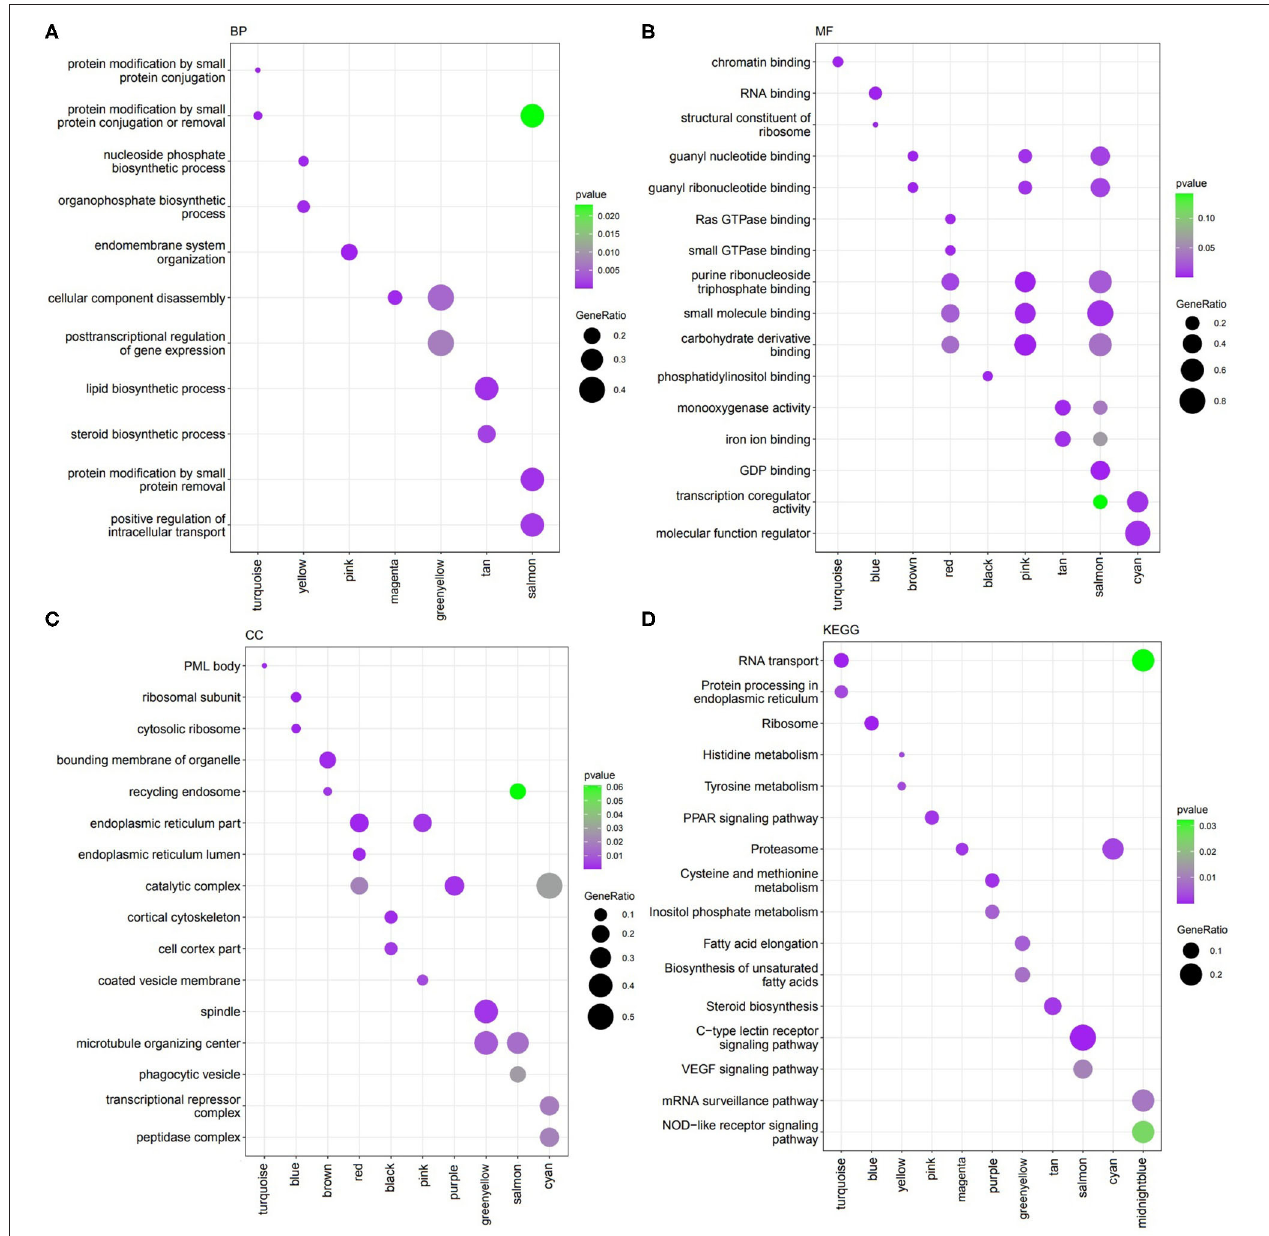
FIGURE 2 | Functions identified by clusterProfiler. (A) Biological Process (BP). (B) Molecular Function (MF). (C) Cellular Component (CC). (D) KEGG